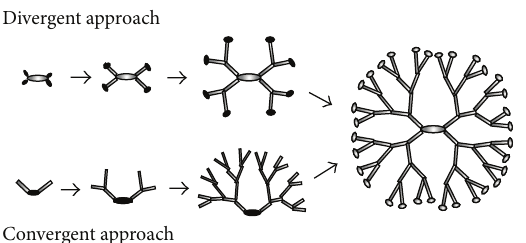
Figure 1: Sketch of the two synthesis protocols for the construction of dendritic macromolecules. Black regions highlight the functional sites.